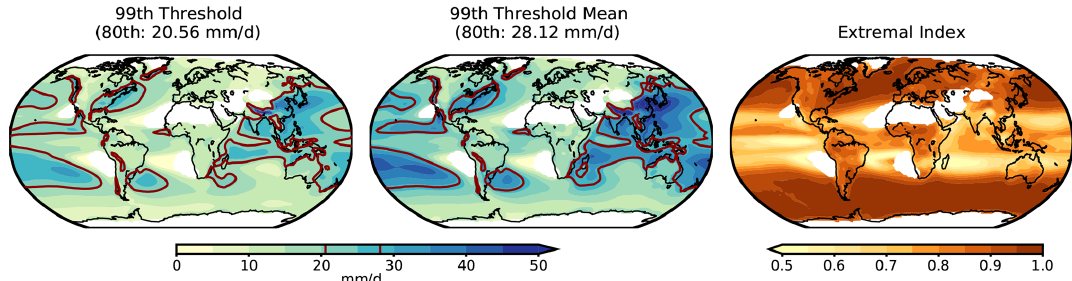
Figure 7. The thresholds for extreme precipitation (defined as the 99th percentiles of daily precipitation relative to the 3351-year distribu- tions), means of the values above these thresholds, and extremal indices in the 1501BCE–1849CE full-forcing simulation. The brown line indicates the spatial 80th percentile level to discern wet regions (above the 80th percentile) from others.